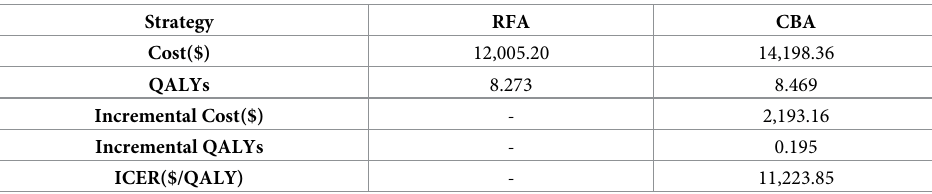
Table 2. Results of base case cost-effectiveness